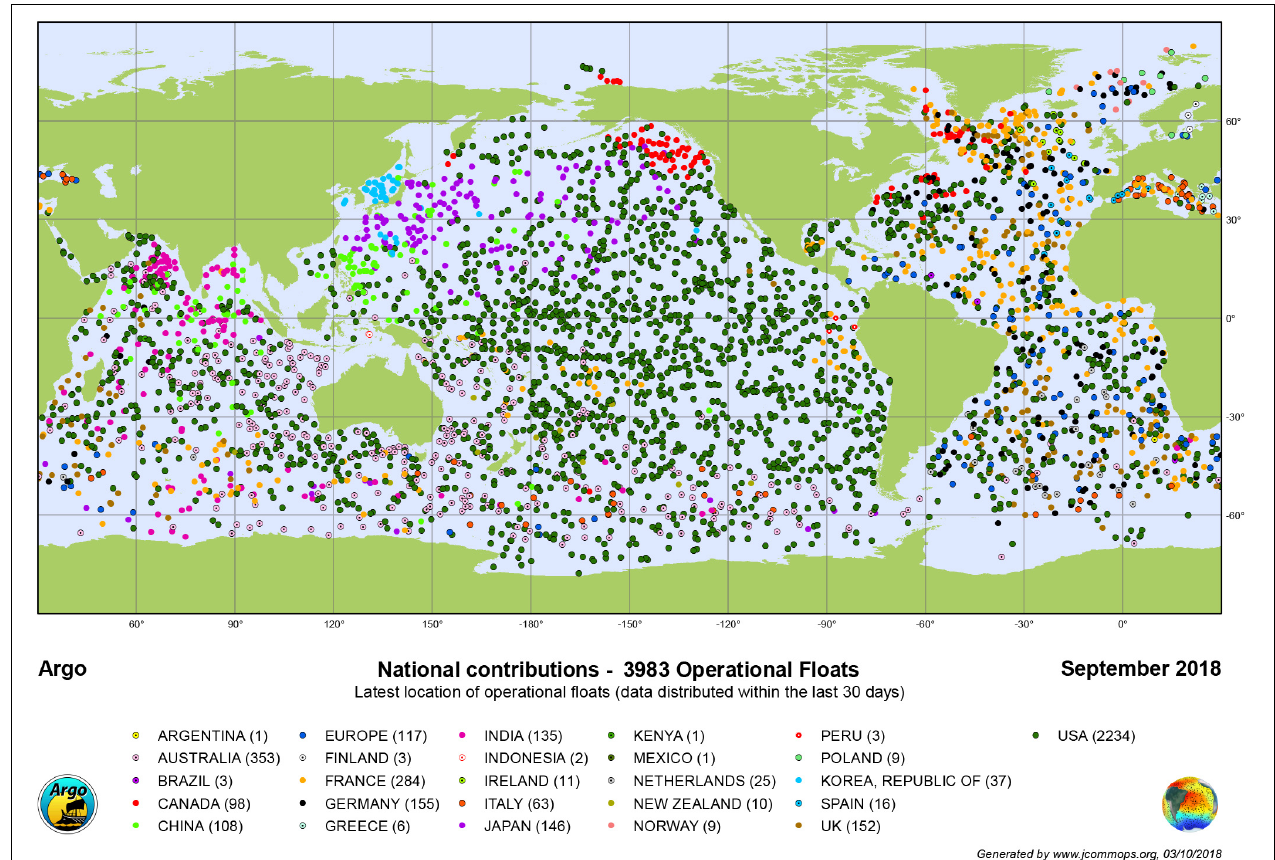
FIGURE 5 | Global map of operational Core Argo floats, by nation, in September 2018 (Source: